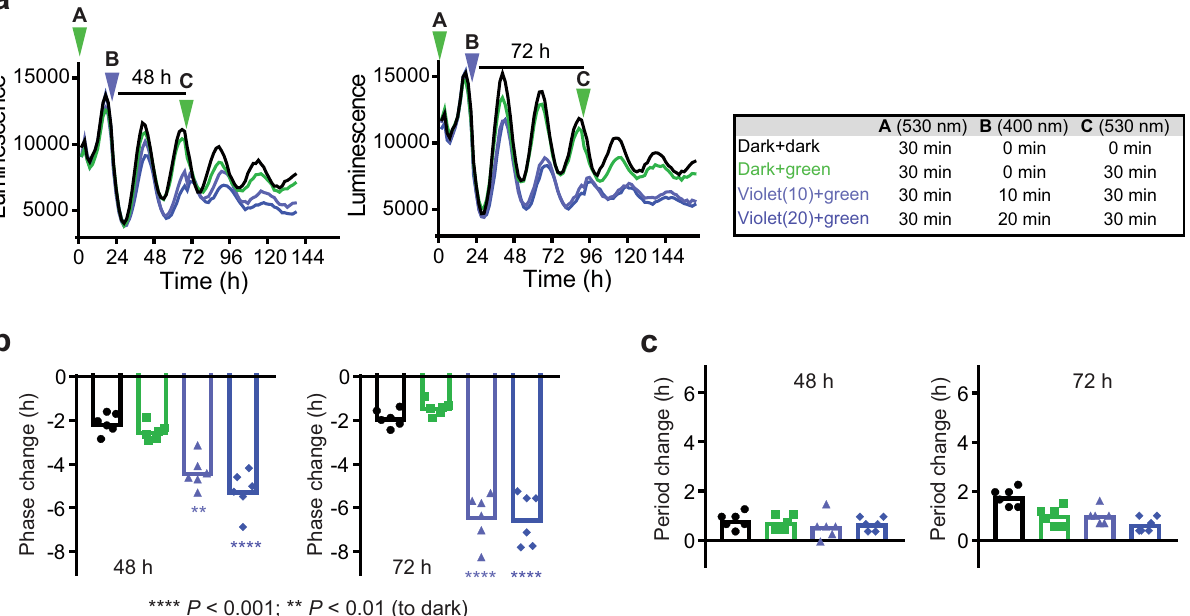
Fig. 7 Circadian phase control using chronophotopharmacology. Green light ( λ max = 530 nm)-irradiated compound 9 was applied to U2OS cells at 0 h (A). On the next day (B), the cells were irradiated with violet light ( λ max = 400nm) for 0 min (black and green lines), 10 min (light violet line), or 20 min (dark violet line). After 48 h or 72 h (C), the cells were irradiated with green light ( λ max = 530 nm) for 0 min (black line) or 30 min (green, light violet, and dark violet lines). Luminescence rhythm pro fi les (average of n = 6) are shown in a . Phase and period changes relative to DMSO controls after time point C are shown in b and c , respectively. Data for DMSO-treated cells are shown in Supplementary Fig. 29. Luminescence is given in arbitrary units. n = 6 biologically independent samples. One-way ANOVA followed by a Tukey ’ s multiple comparisons test was used for statistical analysis. P value is shown in the fi